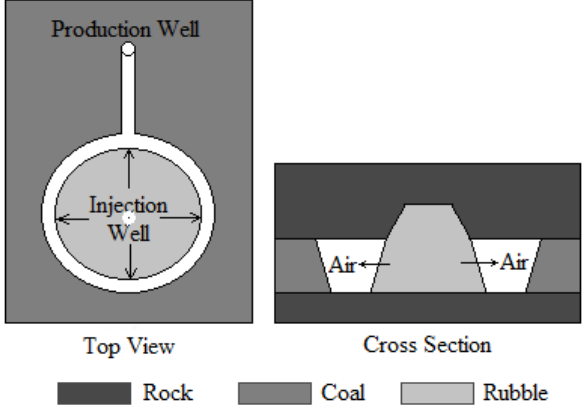
Figure 31. Channel formation in thin seams (Modified from Kuyper et al. [60]).